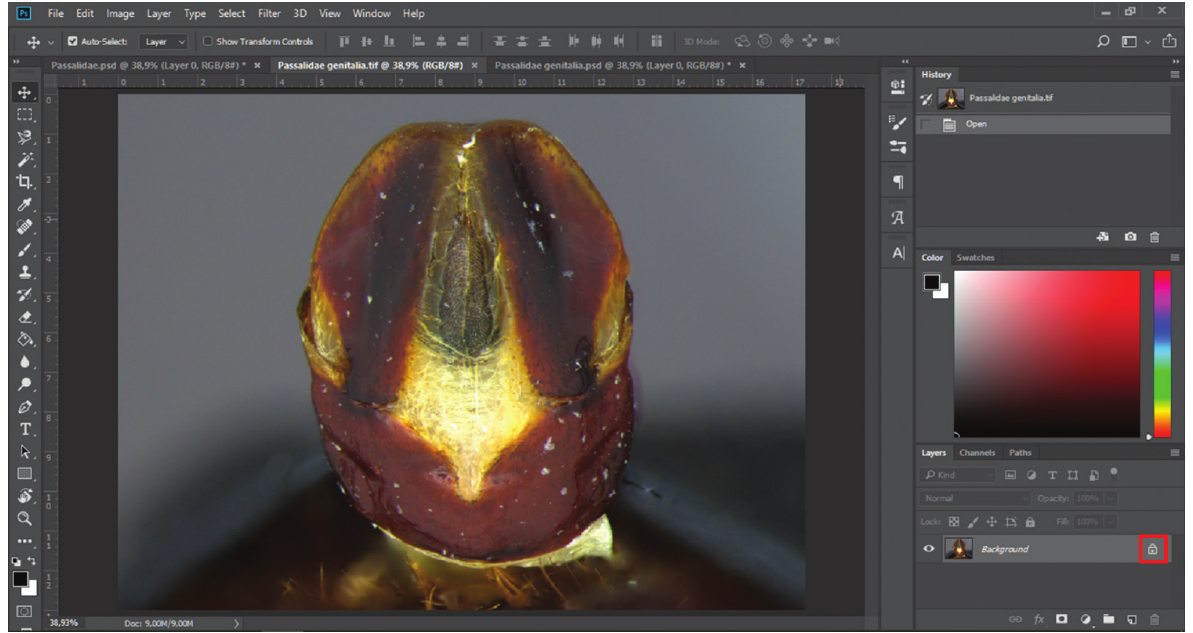
Figure 12. Image containing dust particles where the background is not completely homogeneous. Highlight the padlock icon that can lock or unlock the layer.